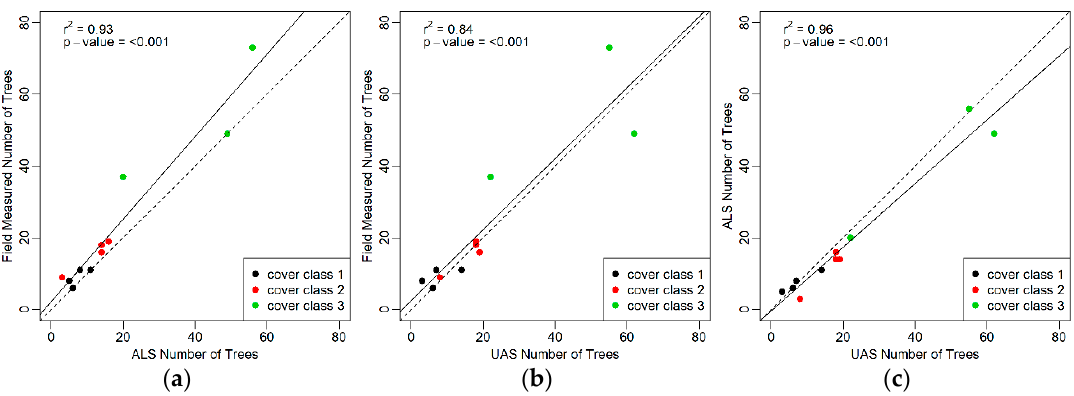
Figure 5. ( a ) ALS-based and ( b ) UAS-photogrammetry-derived estimates of plot tree counts vs. field-measured counts or ( c ) vs. the opposing remote sensing method by canopy cover class. The solid line displays a linear regression fit and the dashed line the 1:1 line.